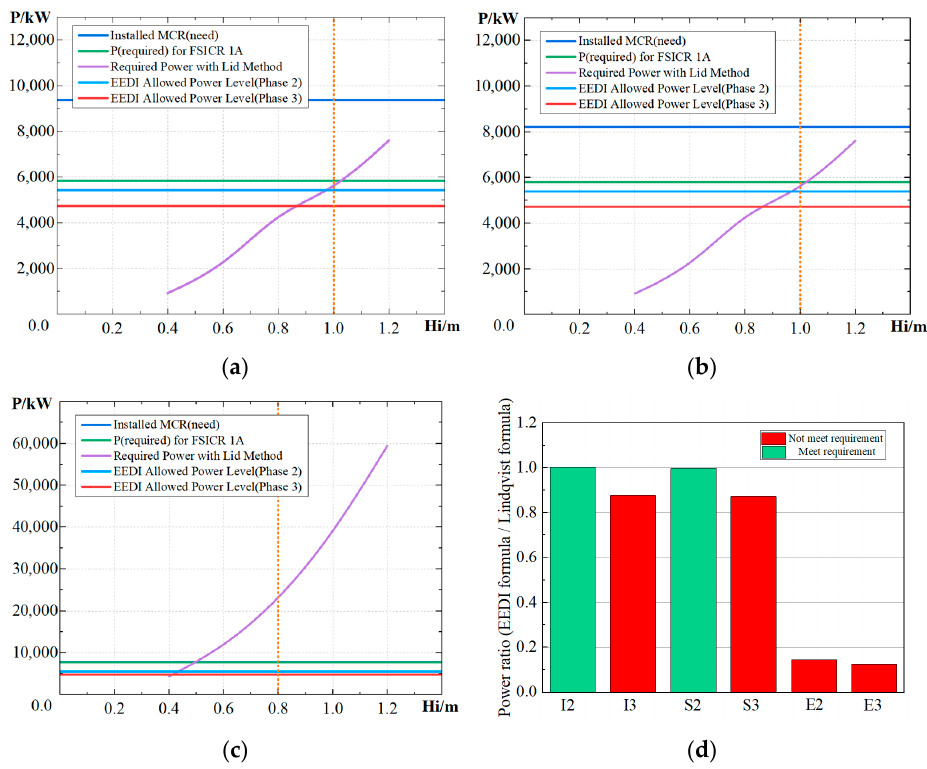
Figure 9. Power requirement results for 1A. ( a ) Power of traditional icebreaker bow, ( b ) Power of semi bow, ( c ) Power of EEDI type of bow form, ( d ) Power requirement comparison.